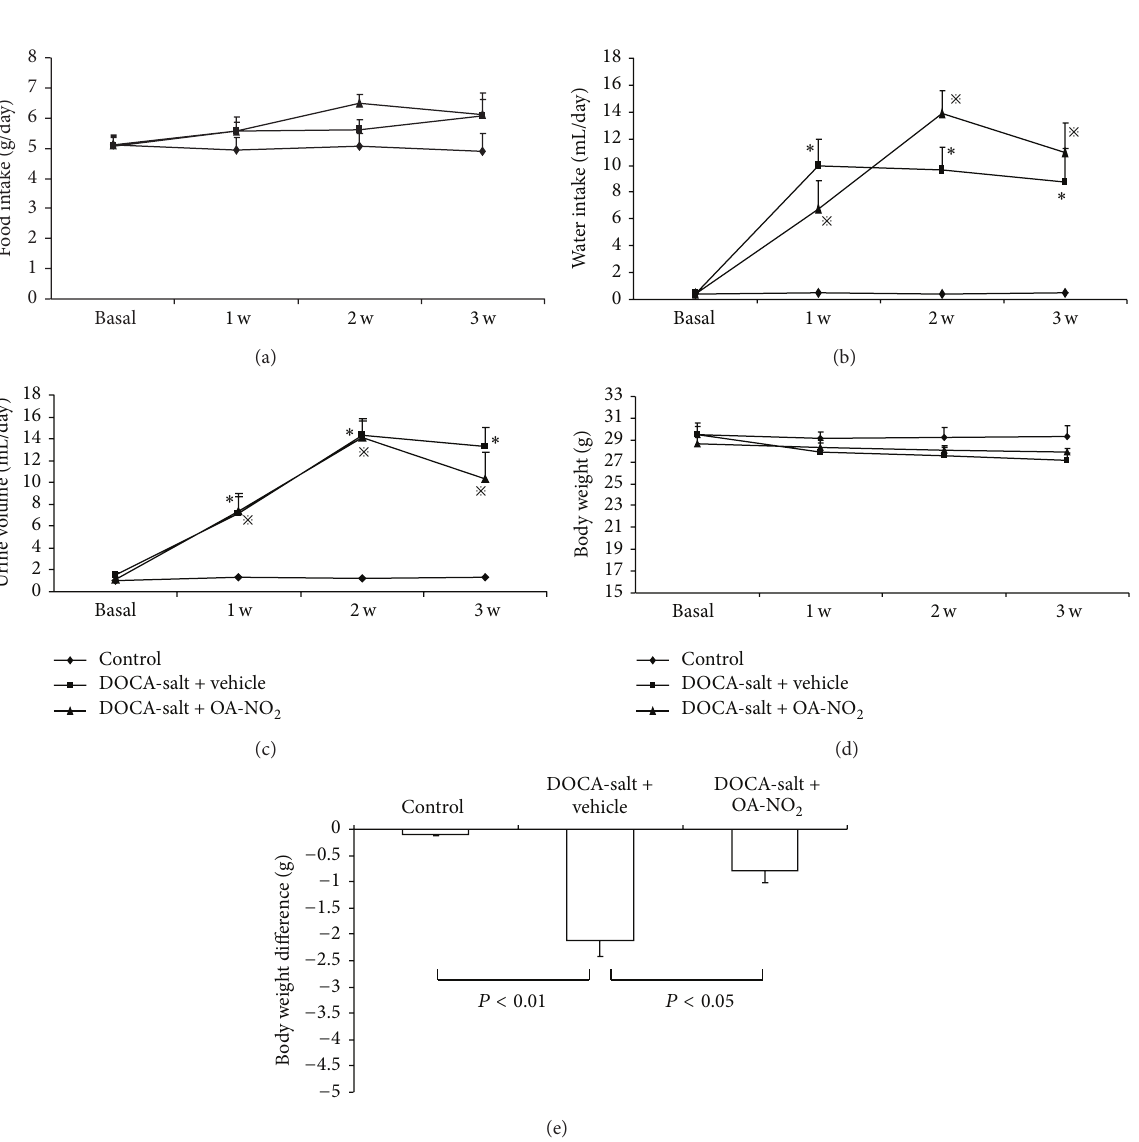
Figure 1: Food intake (a), water intake (b), urine volume (c), body weight (d), and body weight difference (e) in control ( 𝑛 = 5 ), DOCA-salt + vehicle ( 𝑛 = 8 ), and DOCA-salt + OA-NO 2 ( 𝑛 = 8 ) mice. ∗ 𝑃 < 0.05 , compared with control; n 𝑃 < 0.05 , compared with control; data are shown as mean +